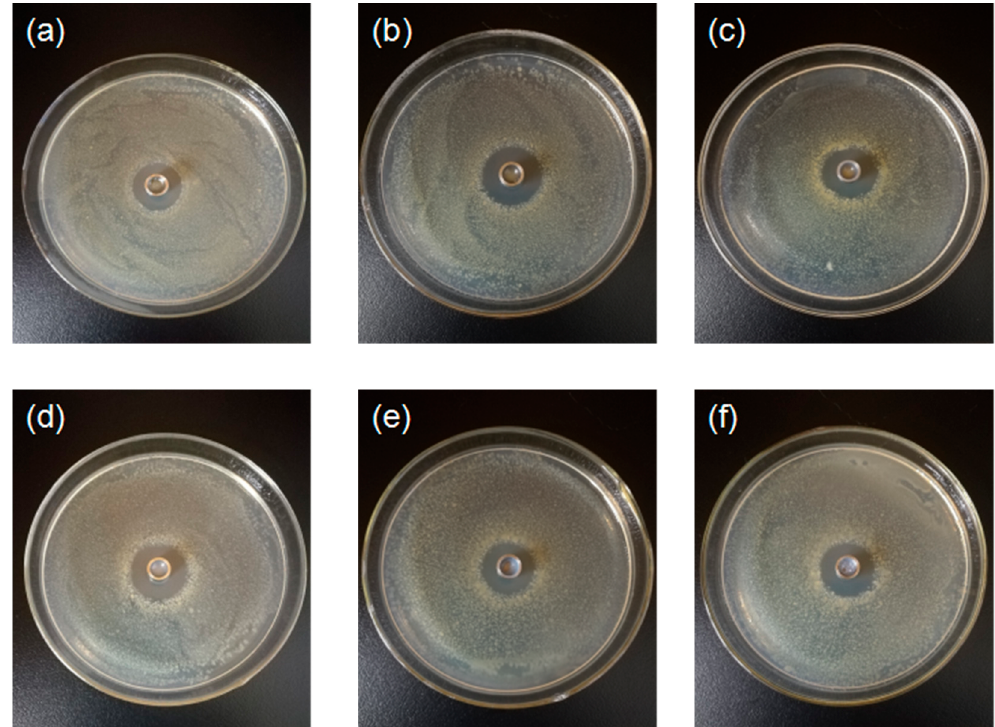
Figure 9. Inhibition zone for E.coli after the treatment by the chitosan-based coating film with TiO 2 nanoparticles ( a ) 0; ( b ) 0.01%; ( c ) 0.03%; ( d ) 0.05%; ( e ) 0.07%; ( f ) 0.09%.